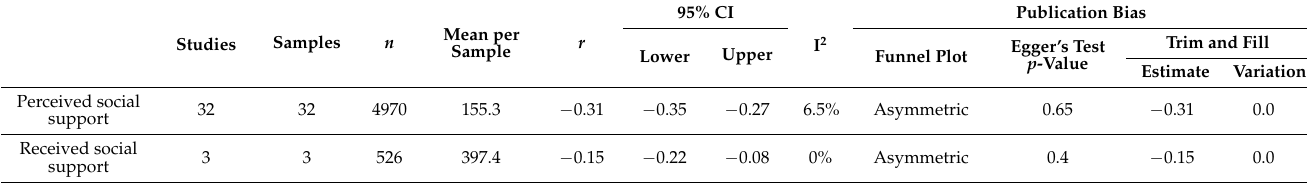
Table 3. Summary of the meta-analysis results.